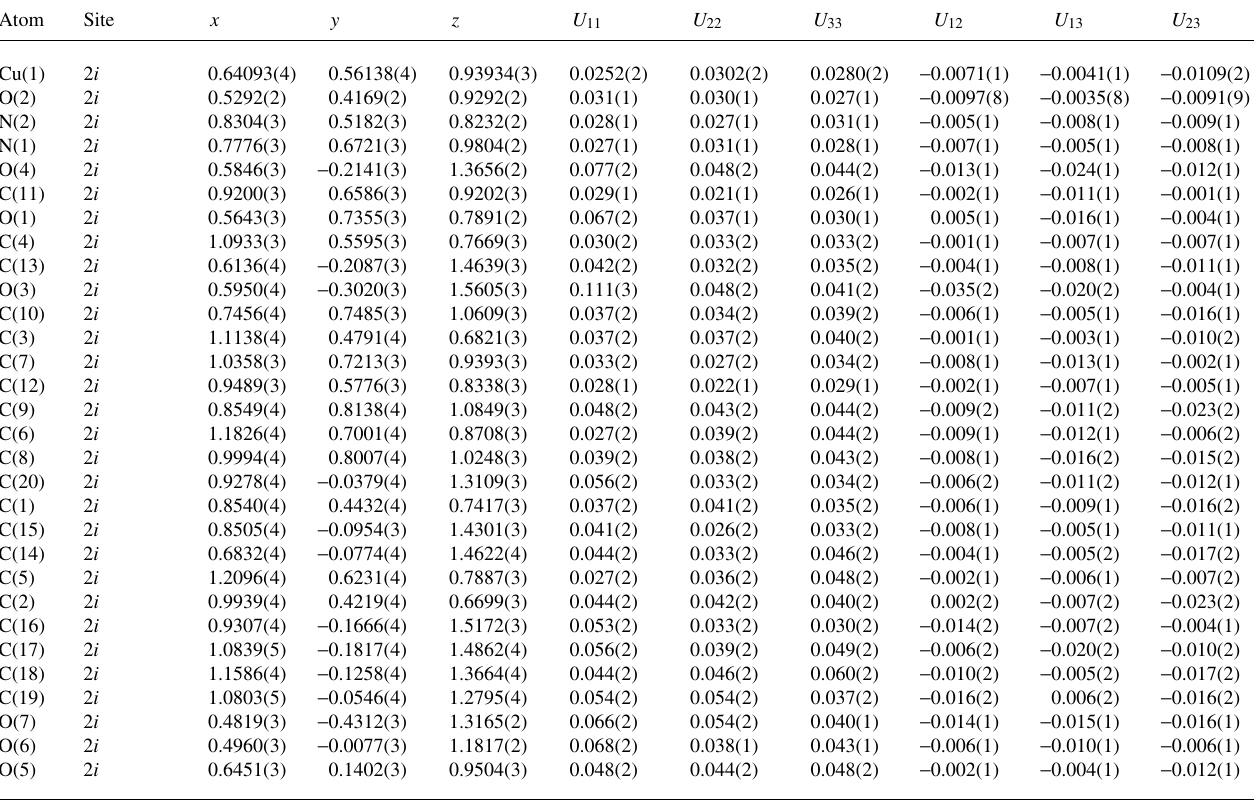
Table 3. Atomic coordinates and displacement parameters (in Å 2 )